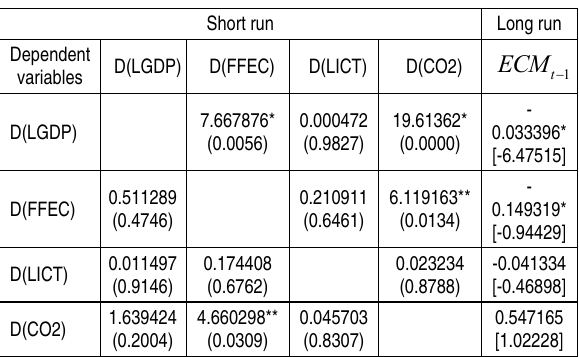
Table 4. The VECM Granger causality analysis Short run Long